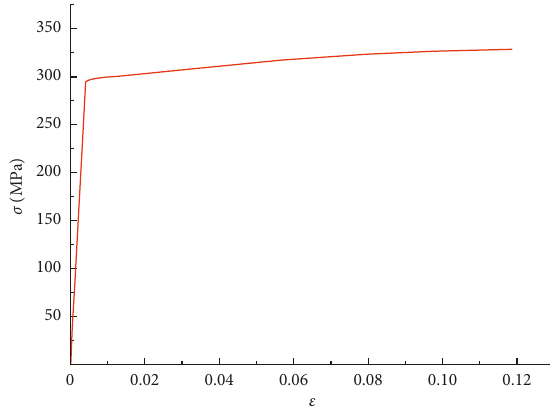
Figure 3: The stress-strain curve of aluminum alloy 6005A.